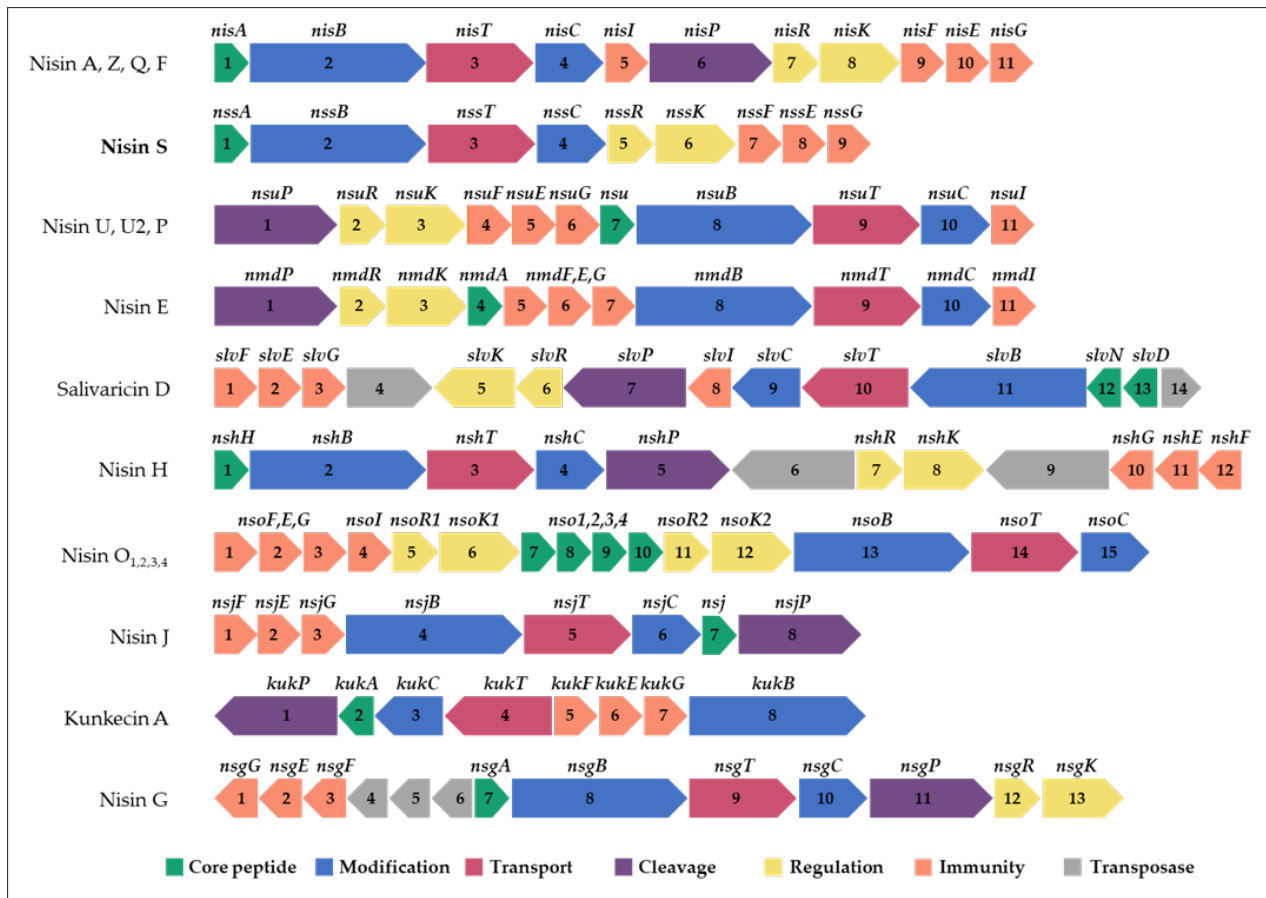
Figure 2. Comparison of bacteriocin gene clusters of different nisin variants. ORFs are indicated by numbers, and those with a known function are indicated by gene identification and color.